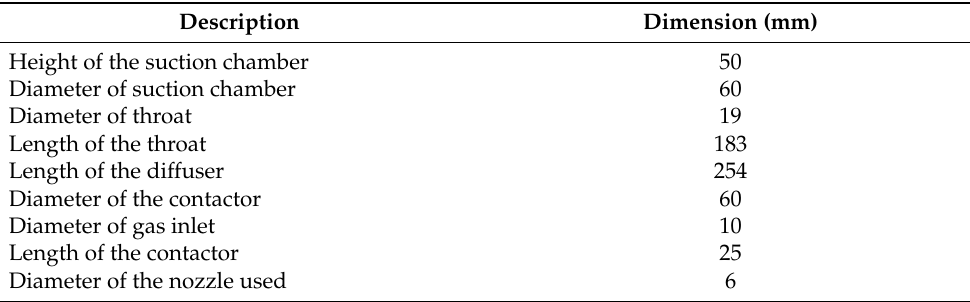
Table 1. Dimensions of the liquid–gas ejector